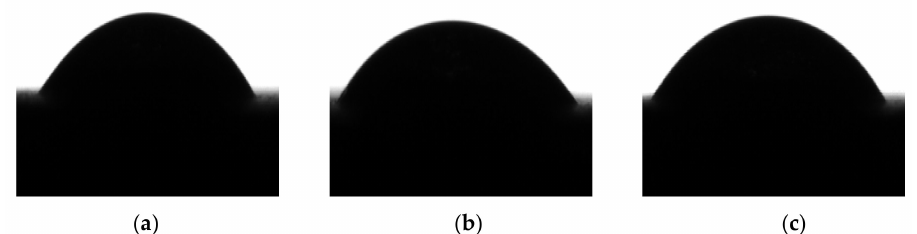
Figure 6. The contact angle for surface of the coated cast iron: ( a ) DWW1 (contact angle: 48.3 ◦ ); ( b ) DWW2 (contact angle: 44.9 ◦ ); ( c ) DWW3 (contact angle: 48.4 ◦